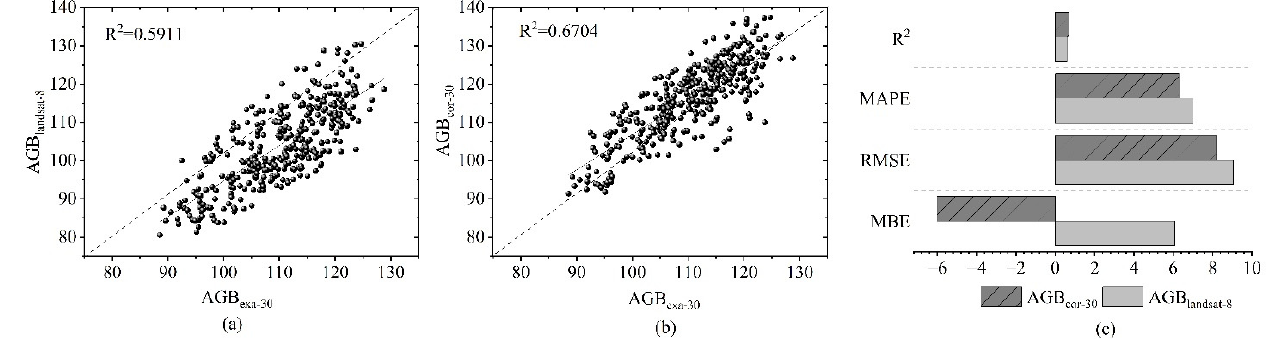
Figure 8. Scatter plot of the pre- and post-correction results and true AGB and the accuracy comparison of 30 m. ( a ) Scatter plot of the pre-correction results and true AGB at 30 m; ( b ) scatter plot of the post-correction results and true AGB at 30 m; ( c ) accuracy comparison.